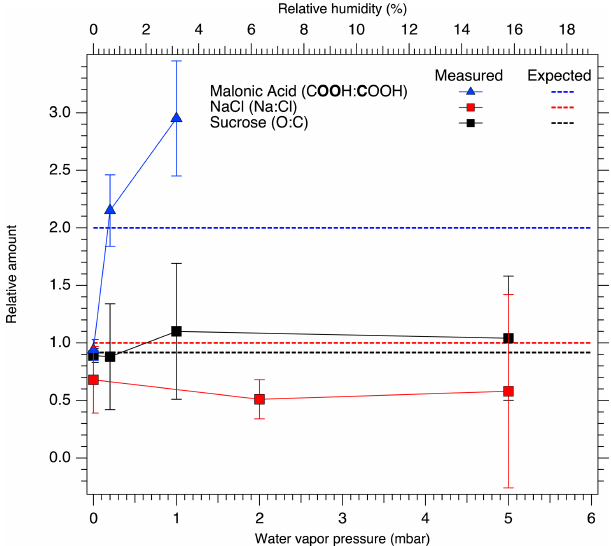
Figure 4. Relative peak areas for NaCl (Na:Cl, red), sucrose (O:C, black), and carbon to oxygen in the malonic acid carboxyl group (COOH (O 1s):COOH (C 1s), blue). The dashed horizontal red, black and blue lines show the expected stoichiometric ratio for NaCl, sucrose and malonic acid, respectively. Relative ratios differ- ing from the stoichiometric ratio indicate changes in the chemical composition of the surface of the aerosol